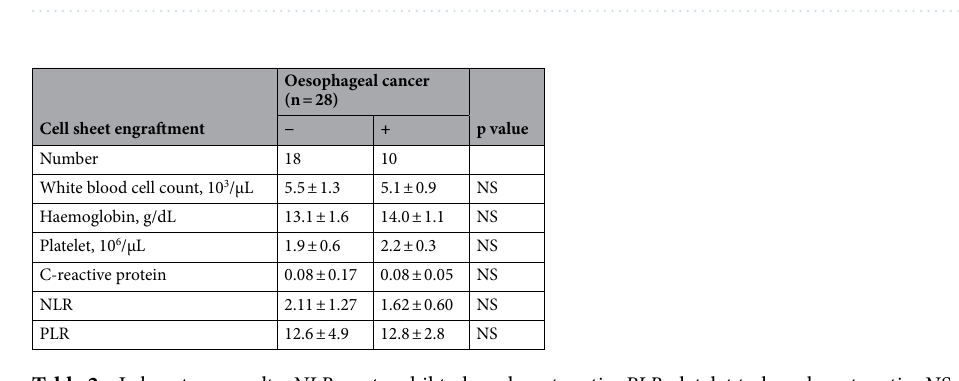
Table 2. Laboratory results. NLR neutrophil to lymphocyte ratio, PLR platelet to lymphocyte ratio, NS not significant.